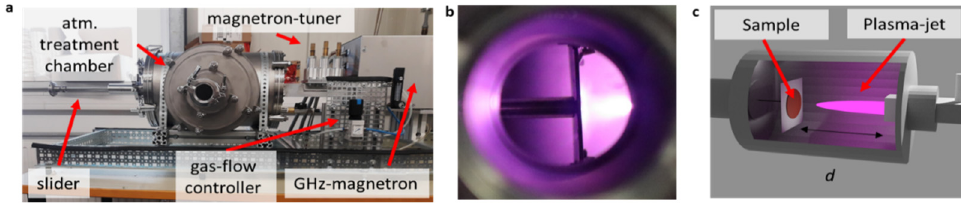
Figure 1. ( a ) Photograph of the atmospheric plasma-jet carbonization apparatus. Red arrows in ( a ) indicate the individual components. ( b ) Photograph inside the treatment-chamber, during plasma- jet carbonization. ( c ) Illustration of the plasma-jet carbonization setup, with the distance d between the sample and the plasma-jet nozzle.